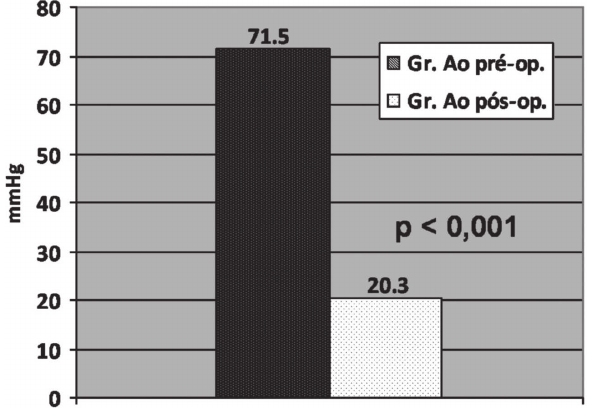
Fig. 4 - Comparação dos gradientes de pressões aórtica no pré- operatório (Gradiente Ao pré-op.) e no pós-operatório (Gradiente Ao pós-op.). P = 0,0019 (PAS); P = 0,0023